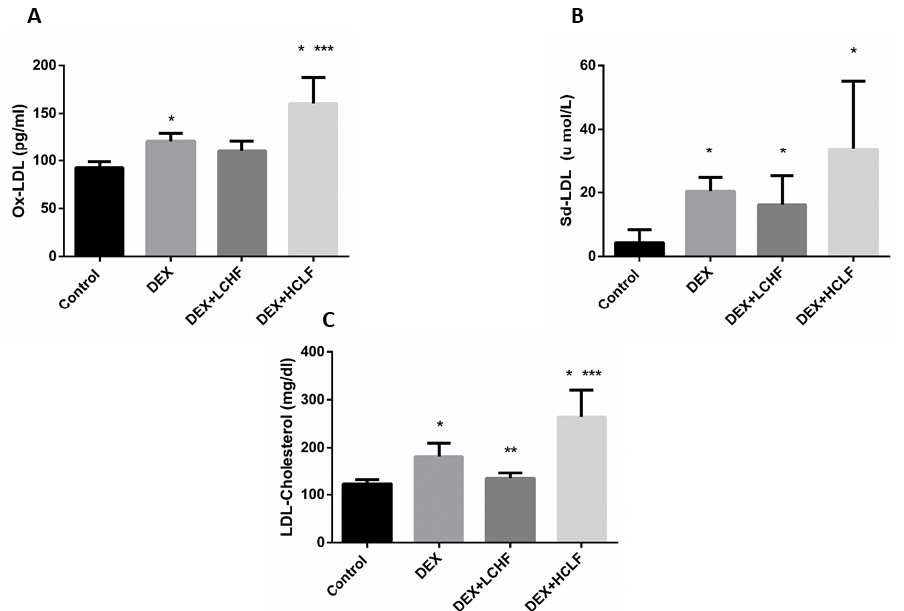
Figure 6. The impact of low-carbohydrate high-fat diet and high-carbohydrate low-fat diet on OX- LDL-Cholesterol ( A ), Sd-LDL-Cholesterol ( B ), and LDL-Cholesterol ( C ) in dexamethasone-treated rats. OX-LDL: oxidized low-density lipoprotein cholesterol; Sd-LDL: small dense low-density lipoprotein cholesterol; LDL-cholesterol: low-density lipoprotein cholesterol. DEX: rats treated with dexamethasone to induce metabolic syndrome; DEX + LCHF: rats treated with dexamethasone to induce metabolic syndrome and fed on low-carbohydrate high-fat diet; DEX + HCLF: rats treated with dexamethasone to induce metabolic syndrome and fed on high-carbohydrate low-fat diet. Statistically significant if p ≤ 0.05. *: Statistically significant compared to the Control group. **: Statistically significant compared to DEX group. ***: Statistically significant compared to DEX + LCHF group. LCHF diet modulates the glucose homeostasis in DEX-injected rats.